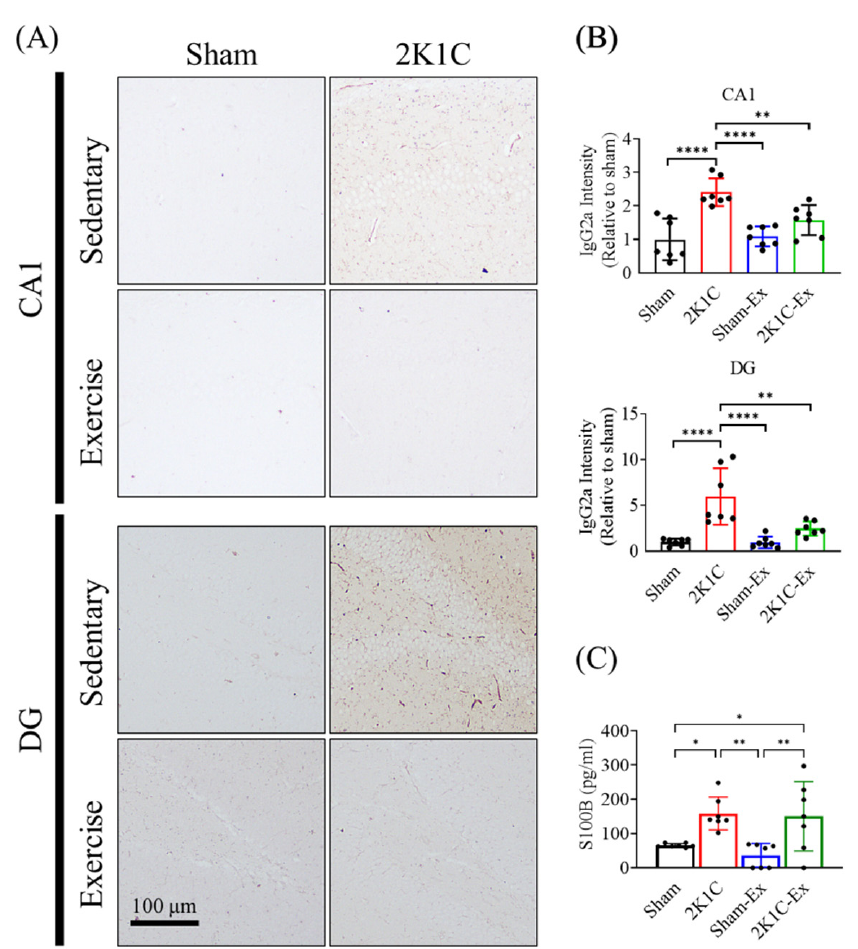
Figure 6. Exercise prevents the 2K1C-hypertensive mouse model hippocampus BBB leakage. ( A ) The immunohistochemistry micrographs for the mouse-IgG2a staining in the hippocampus CA1 and dentate gyrus (DG). ( B ) The quantitative result for IgG2a antibody level in the hippocampus CA1 and DG. ( C ) The plasma S100B level was measured by ELISA. The statistical analysis was performed by one-way ANOVA and Holm-Sidak’s multiple comparisons. The averaged data and s.d. are plotted. The sample sizes are seven for each group. *: p < 0.05, **: p < 0.01, ****: p < 0.0001. Scale bar, 100 µ